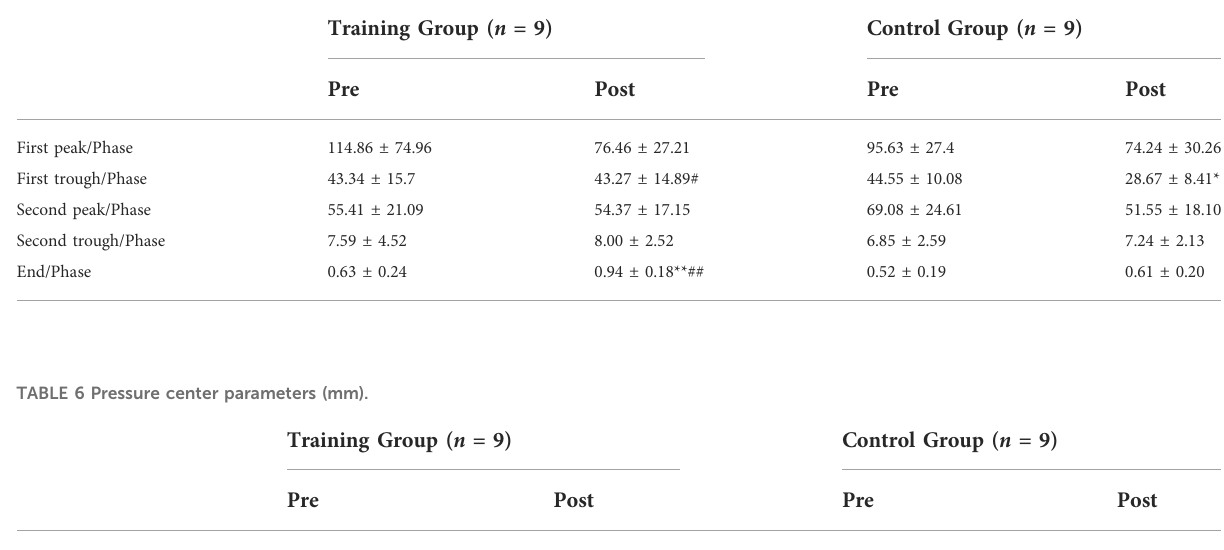
TABLE 5 Vertical force gradient parameter (N/ms).